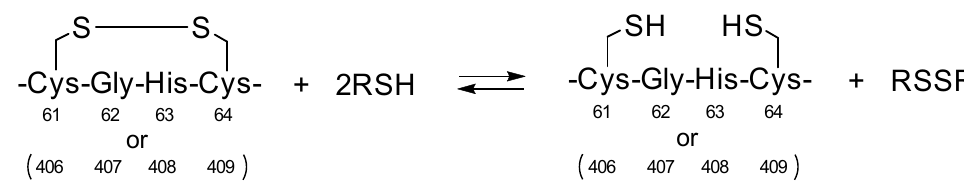
Figure 2. Protein disulfide isomerase (PDI). Overall three-dimensional structure and the active center of PDI (PDB code: 2b5e) ( a ) and its catalytic mechanisms for the SS-related reactions in substrate proteins ( b ).